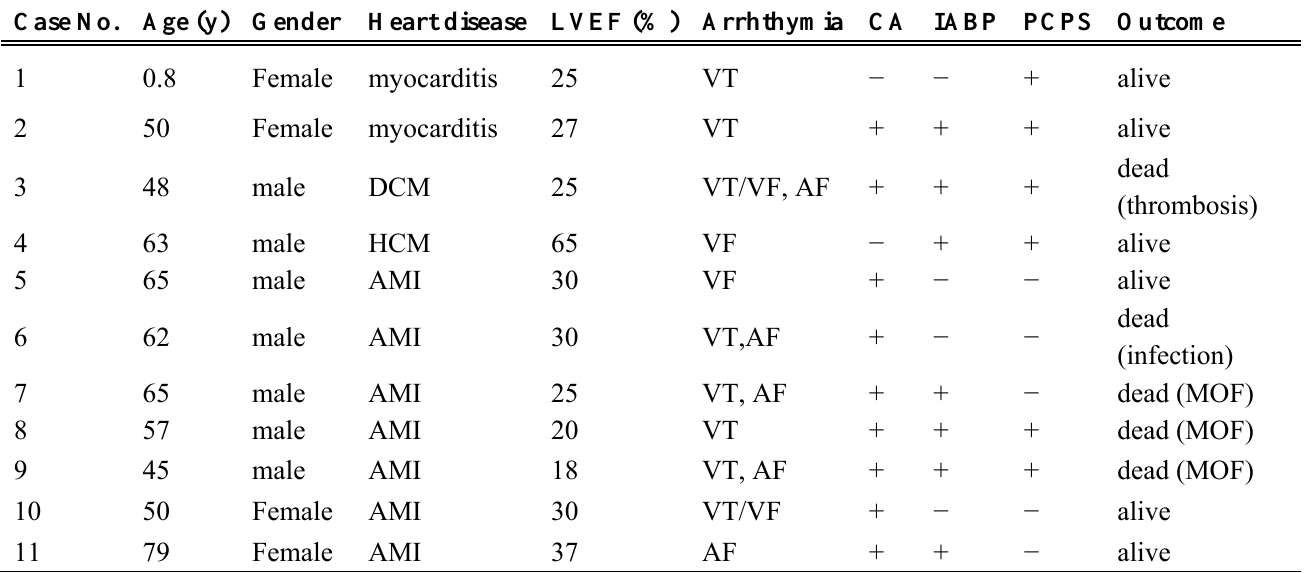
Table 1. Patients’